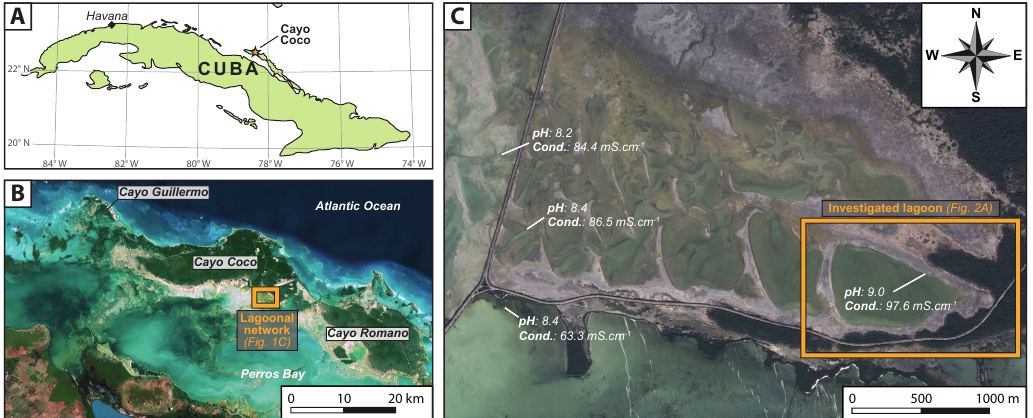
Figure 1. ( A ) Map of Cuba showing the location of Cayo Coco, in north coast of the island. ( B ) Satellite image of Cayo Coco and the Perros Bay coastal lagoon. The Cayo Coco lagoonal network is located in the southern side of Cayo Coco and connected to Perros Bay on its western side. ( C ) Satellite image on the eastern side of the Cayo Coco lagoonal network. Marine influence decreases toward the east, inversely from the confinement which gradually increases eastward. The hydrological parameters (pH and conductivity) were measured on 23 and 24 July 2014. Both Satellite images are provided by Flash Earth (with Bing maps), © Microsoft Corporation—Imagery © Harris Corp, Earthstar Geographics